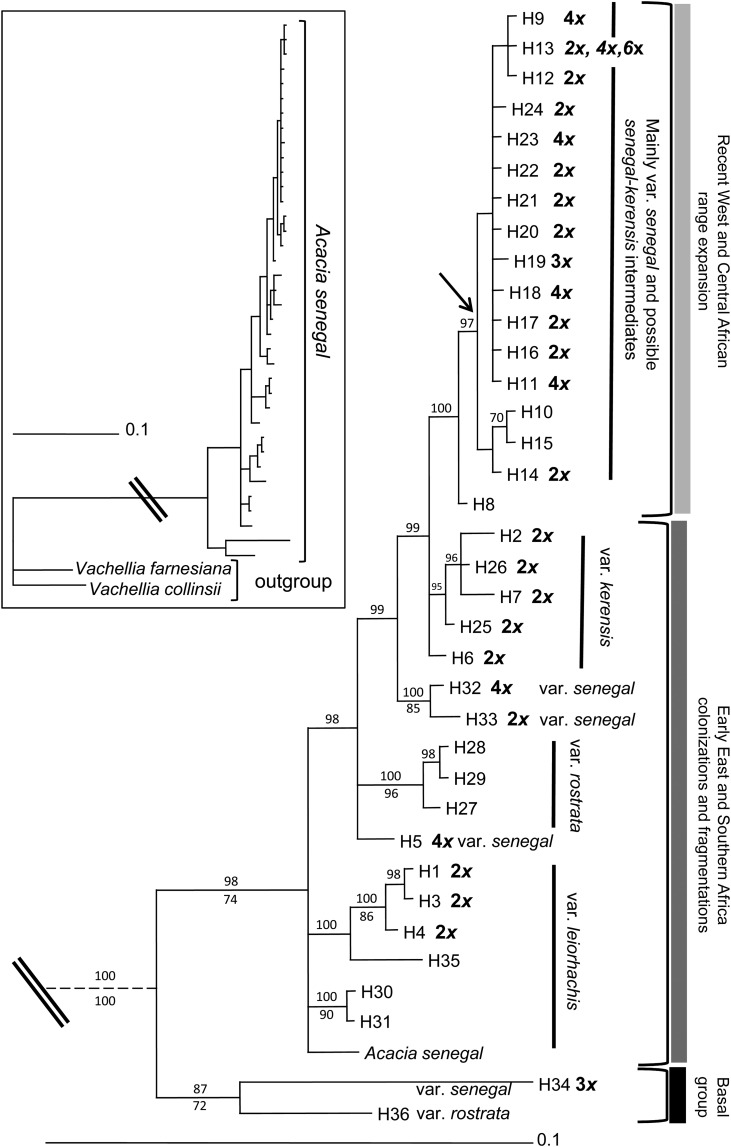
Bayesian 50 % majority-rule consensus phylogram of ITS sequences (GenBank accession numbers HQ605042–HQ605077) from Acacia senegal individuals sampled across its distribution range (adapted from Odee et al. 2012). Each haplotype is labelled by H and the number (1–36), followed by the DNA ploidy indicated in bold where analysed. Branches are labelled with ≥70 % bootstrap support (below) and posterior probability (above) values. Arrow indicates presence of a single clade in the maximum parsimony strict consensus tree. The tree was rooted with Acacia (syn. Vachellia) farnesiana and Acacia (syn. Vachellia) collinsii (see inset tree, double line denotes the point at which the break is in the main tree) obtained via GenBank (accession numbers EF638219 and EF638216, respectively). Acacia senegal sequence is accession number EF638213 from Zimbabwe (ploidy unknown). Clades are identified by vertical (dark) lines, labelled with constituent A. senegal varieties (senegal, kerensis, rostrata and leiorhachis). Hypothesized recent range expansion and early colonization and fragmentation events are indicated by light and dark grey vertical bars. Scale bar signifies 0.1 substitutions per nucleotide site.